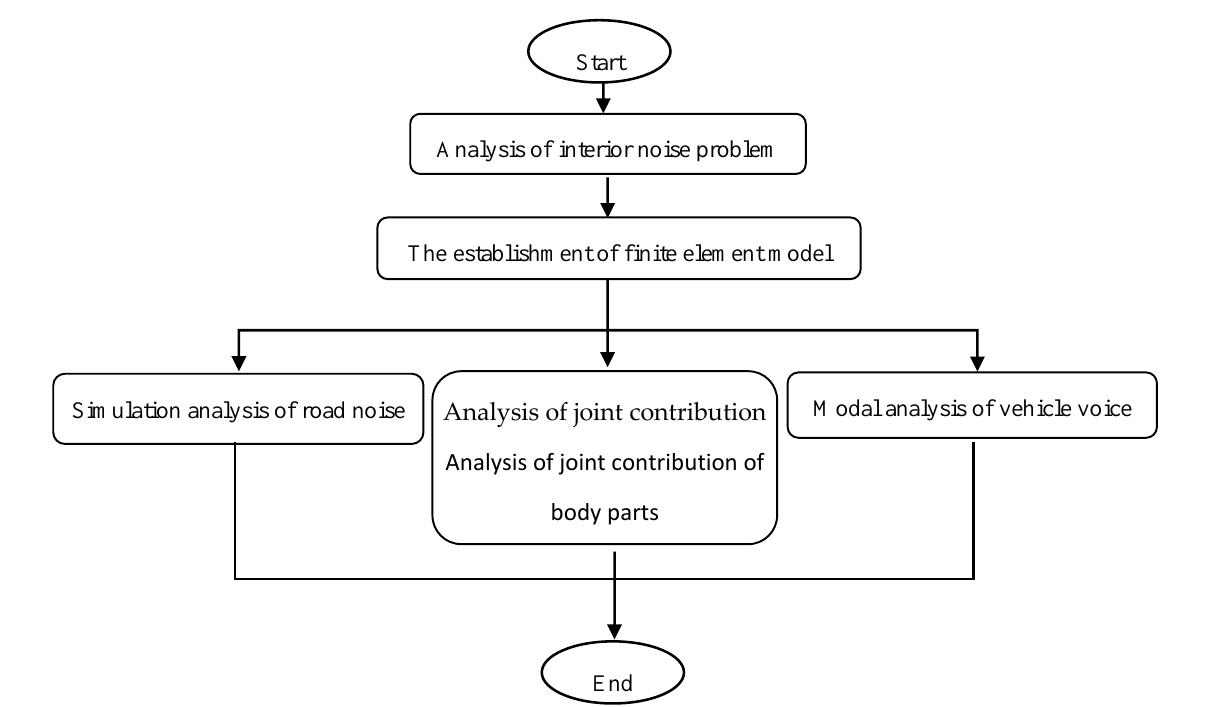
Figure 6. CAE diagnostic analysis flow of low-frequency roaring in the car.